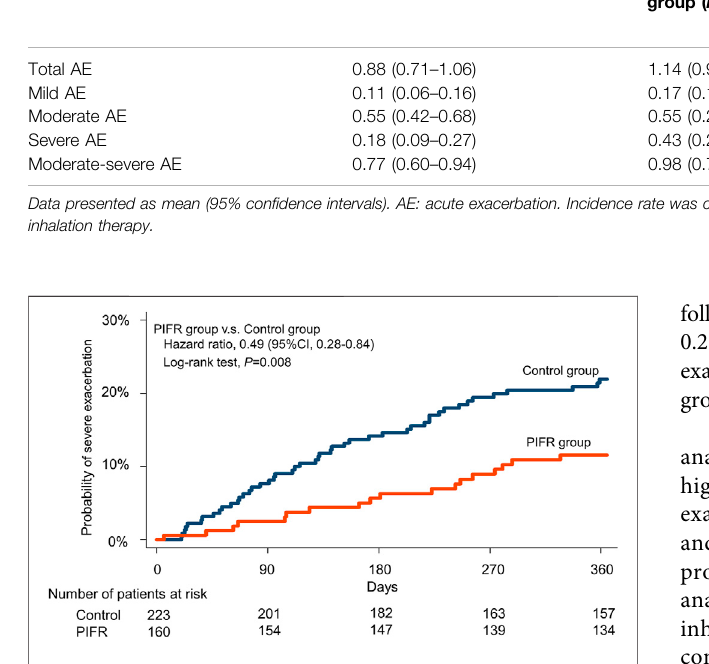
FIGURE4| Kaplan-Meiertime-to-eventplotandlog-ranktestfortimeto fi rst severe acute exacerbation among PIFR group and control group.